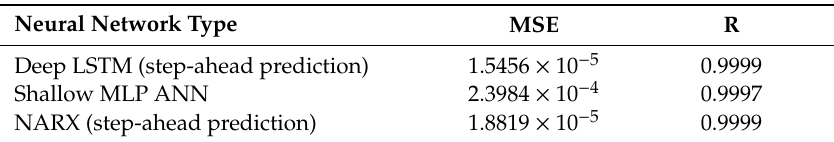
Table 7. The results of neural network tests.